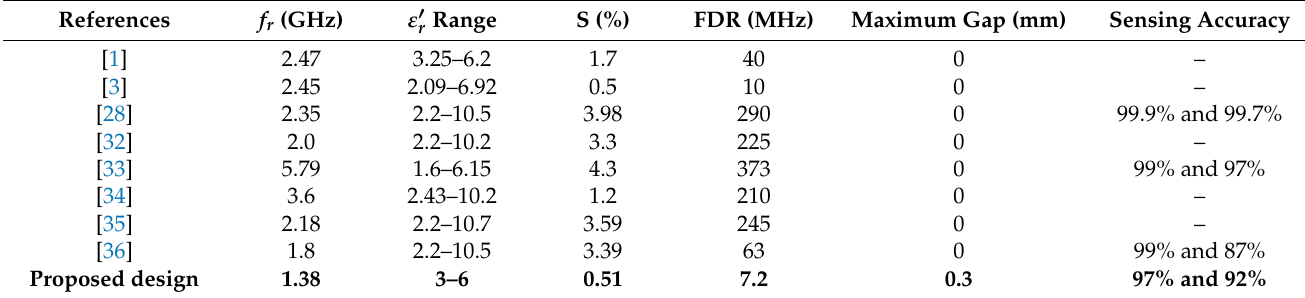
Table 2. Proposed microwave sensor comparison based on complex permittivity analysis with previously reported literature.